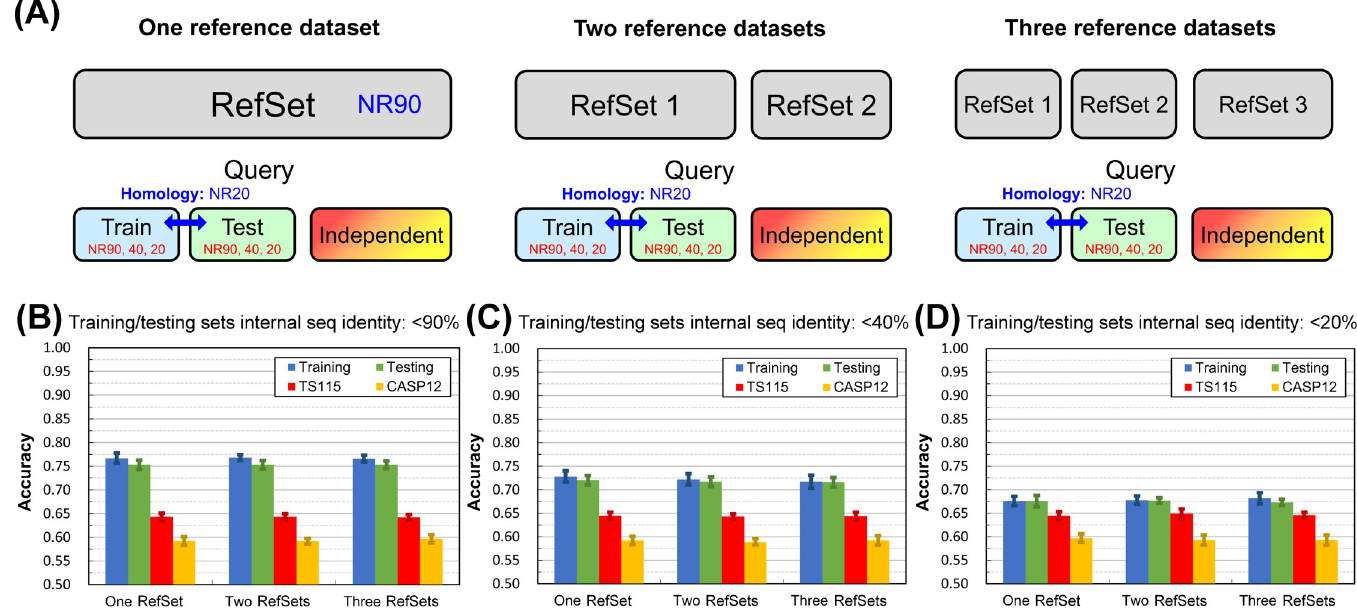
Fig 3. Effects of the isolation of PSSM reference sequences for training and evaluations on secondary structure prediction accuracy. (A) The layout of datasets. The PSSM reference sequences were used as a single dataset or divided into two or three different datasets. Regardless of the number, the size of each reference dataset was 10,000 sequences. The sequence identity cutoff between training and testing query sets (250 sequences for each) was fixed at 20%. Each layout was tested at three levels of inner-dataset homology of training and testing query sets. (B) Results obtained with training/testing sets having inner-dataset sequence identities < 90%. (C) Results obtained with training/testing sets having inner-dataset sequence identities < 40%. (D) Results obtained with training/testing sets having inner-dataset sequence identities < 20%. The isolation of reference sequences did not reduce overfitting. Regardless of whether one or multiple reference sets were used, with a given homology cutoff for sequences within the training and testing sets, the accuracy of each training, testing, and independent test group remained unchanged (see S3 Fig for results of SOV). To conclude, using only one reference set for both training and evaluations, as most previous SSP studies did, would not cause increased overfitting.